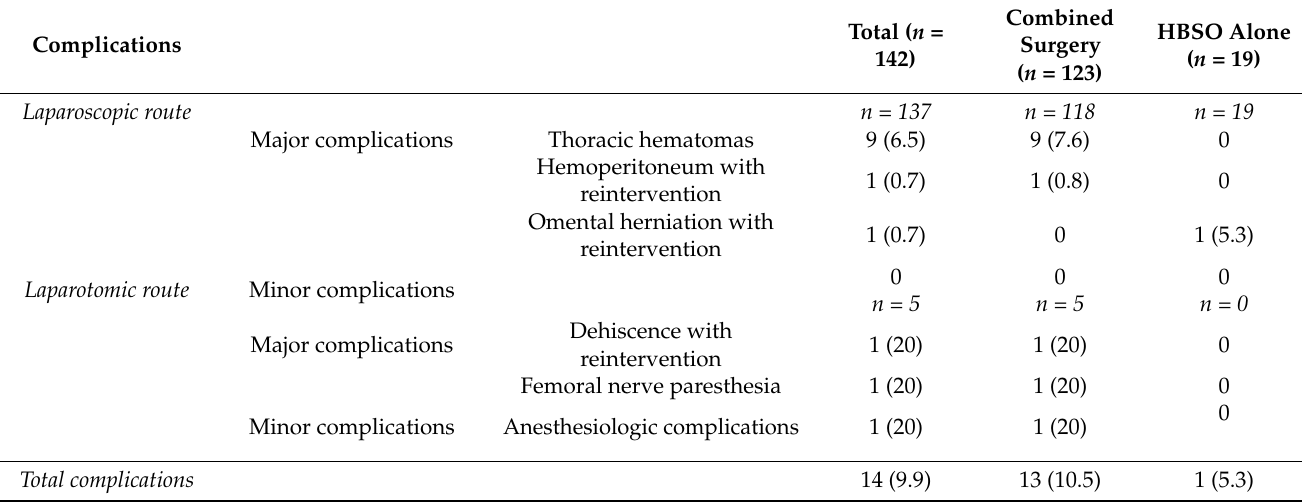
Table 4. Complications during and after surgeries ( n